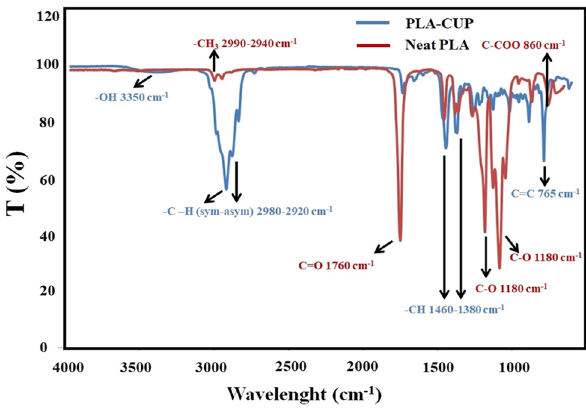
12 times. Figure 2: FT - IR spectrum of neat PLA and PLA - CUP nano fi bers.